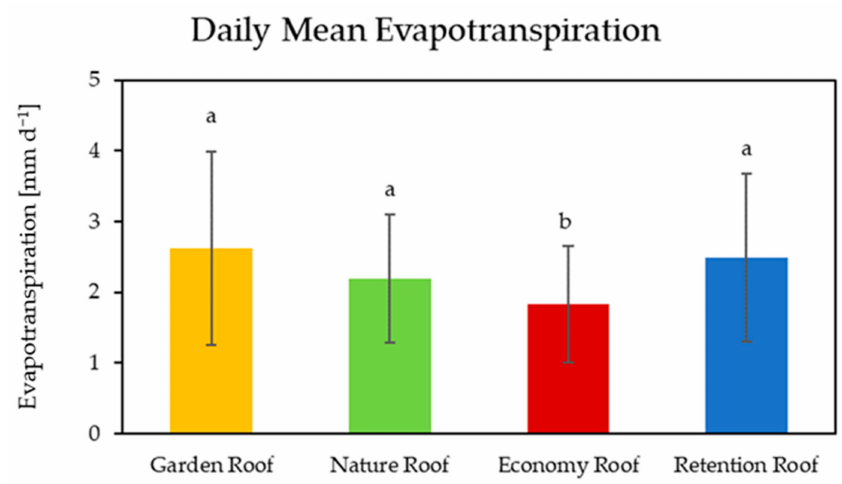
Figure 8. Average daily evapotranspiration of the four different green roofs with means ± SD (n = 121 for Garden Roof ; n = 88 for Nature Roof , n = 134 for Economy Roof and n = 141 for Retention Roof ). Different letters above the whiskers indicate significant differences between means (Friedman Test p < 0.01).